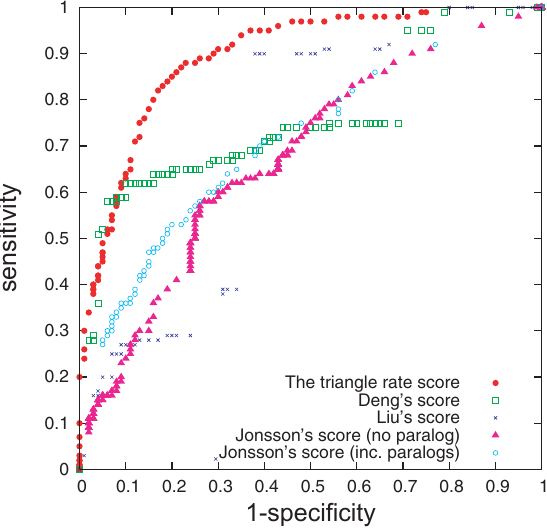
Figure 2. ROC Curves of Predictive Scores. The ROC curves, 1 minus specificity vs. sensitivity, for predicting yeast protein interactions using domain interaction based approaches (Deng et al.’s score and Liu et al.’s score), a homology-based approach (Jonsson et al.’s score plus paralogs) and our network-based approach (the triangle rate score).